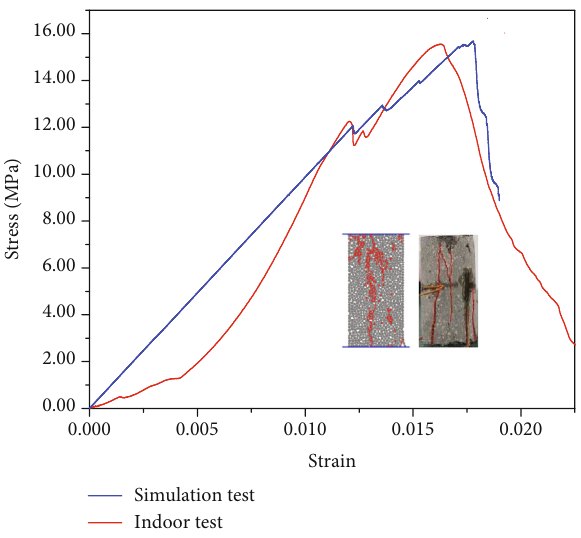
Figure 7: Laboratory test and numerical simulation of the stress- strain curve and fi nal fracture mode of the intact specimen